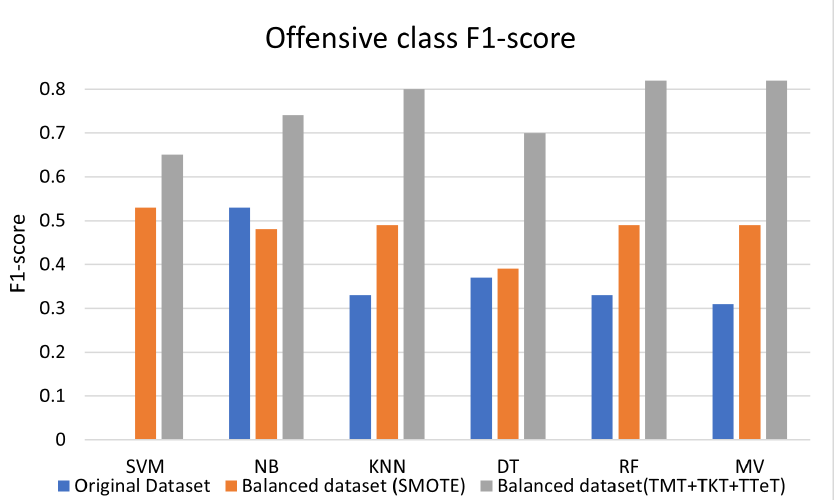
Figure 9. Offensive class F 1 -scores for original and balanced dataset (TMT + TKT +